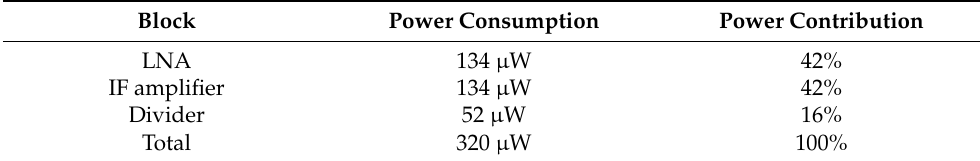
Table 1. Power breakdown of the implemented receiver.